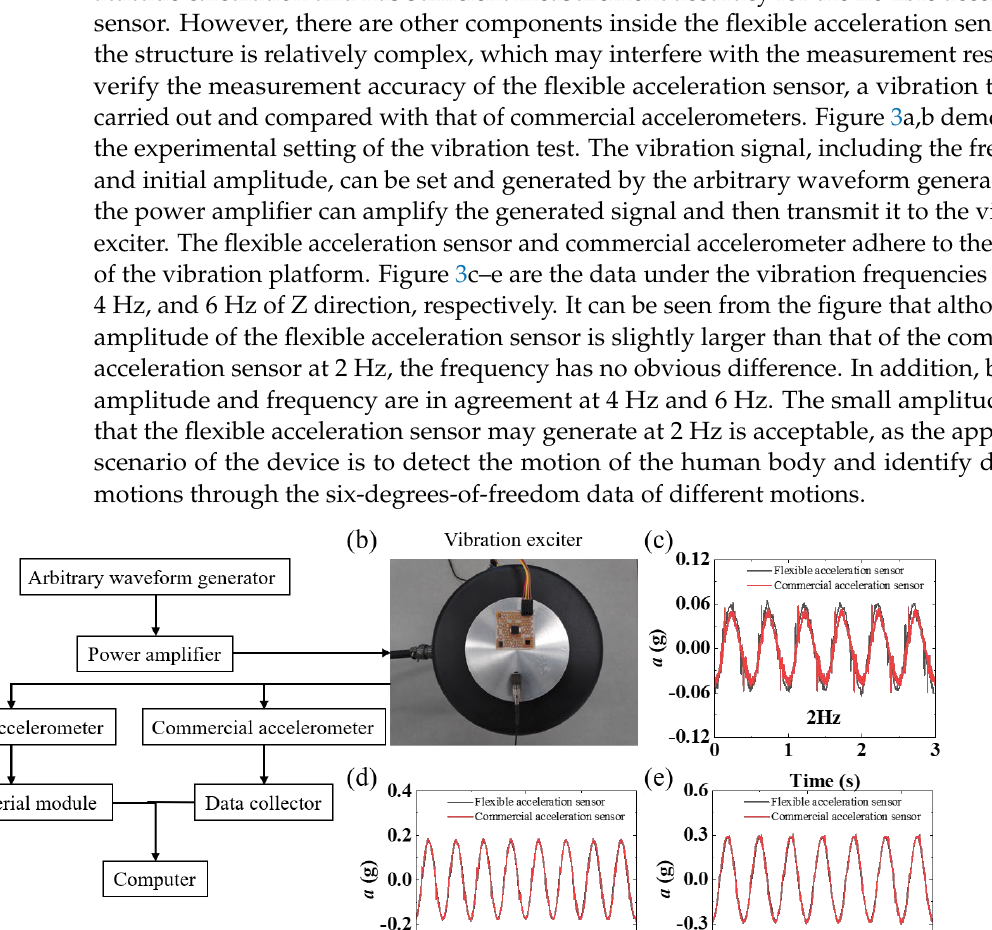
4 of 8 Figure 1. ( a ) Schematic exploded view illustration of the flexible acceleration sensor. ( b ) Two-di-